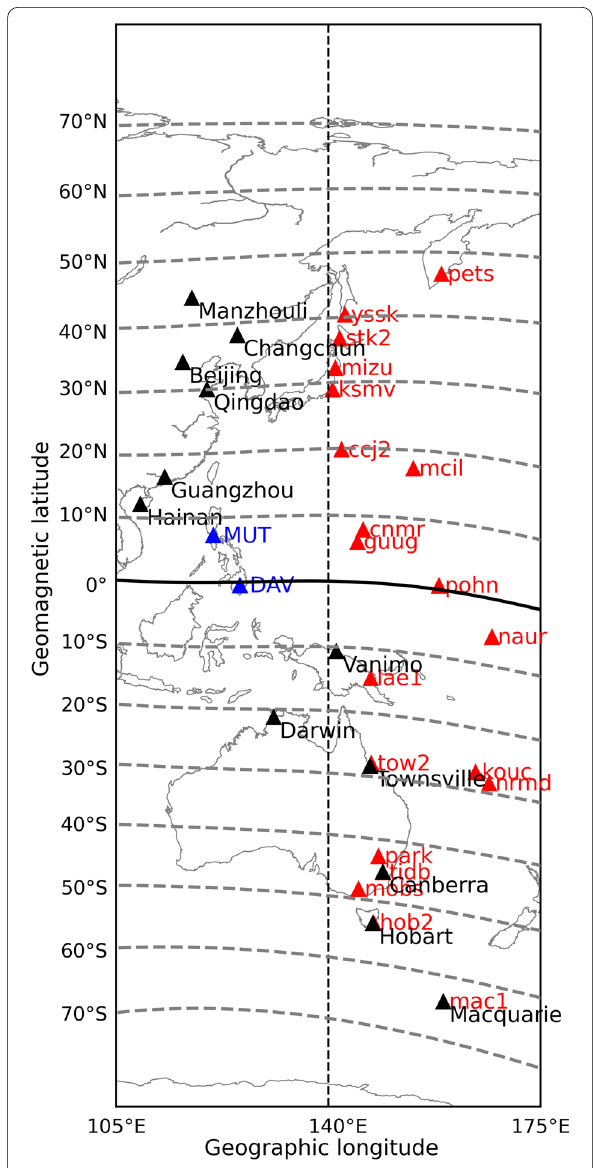
Fig. 1 The locations of the used ground-based observation stations. The curved dashed and solid lines represent the geomagnetic latitudes. The GNSS, ionosonde, and magnetometer stations are illustrated with red, black, and blue triangles,